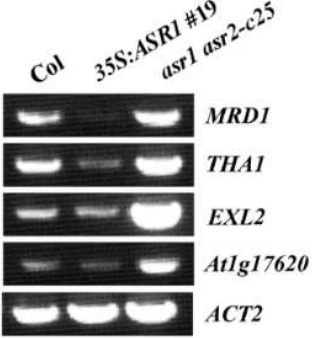
Figure 8. RT-PCR analysis of selected DEGs in the 35S : ASR1 transgenic plants and the asr1 asr2 double mutants. RNA was isolated from 10-day-old seedlings of the Col wild type, the 35S : ASR1 #19 transgenic plants and the asr1 asr2-c25 double mutants and RT-PCR was used to examine the expression of selected DEGs. ACT2 was used as a control.